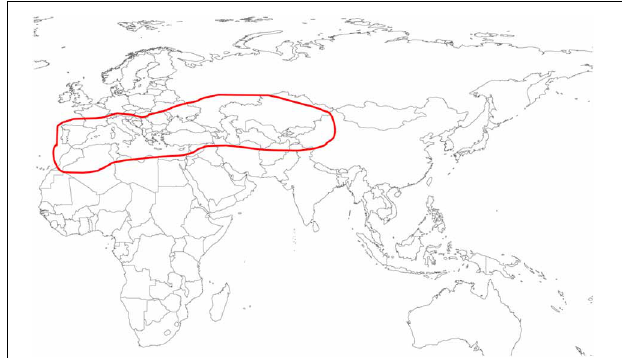
FIGURE 1 | Geographic distribution of Hyalomma marginatum based on (Hoogstraal, 1979), www.kolonin.org and http://www.efsa.europa. eu/en/efsajournal/pub/1723.htm(both accessed April